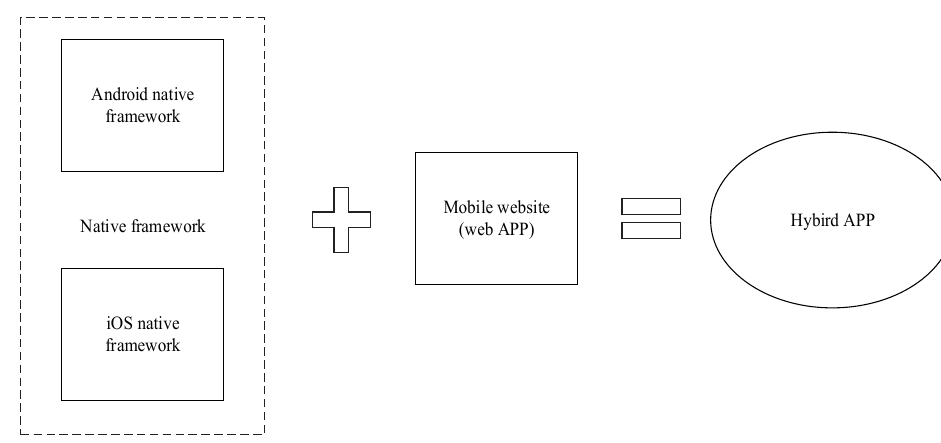
Figure 6. Hybrid application (APP) implementation steps.